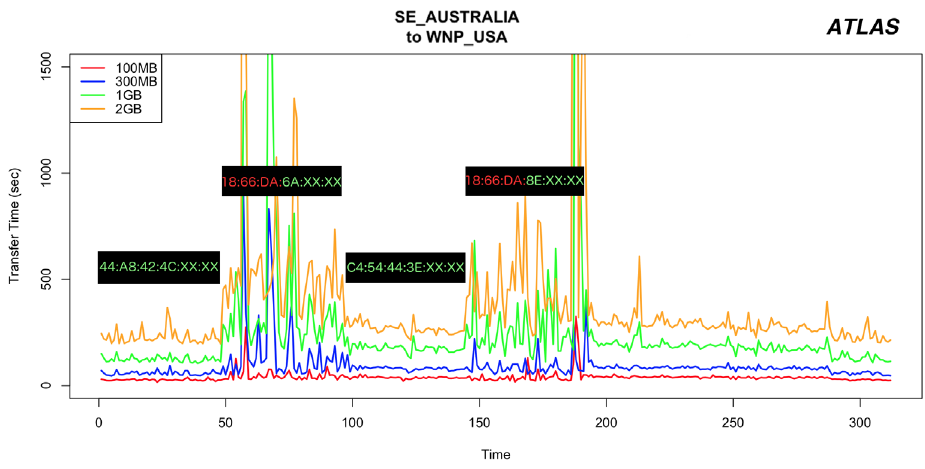
Figure 4. No bottleneck induced by the storage